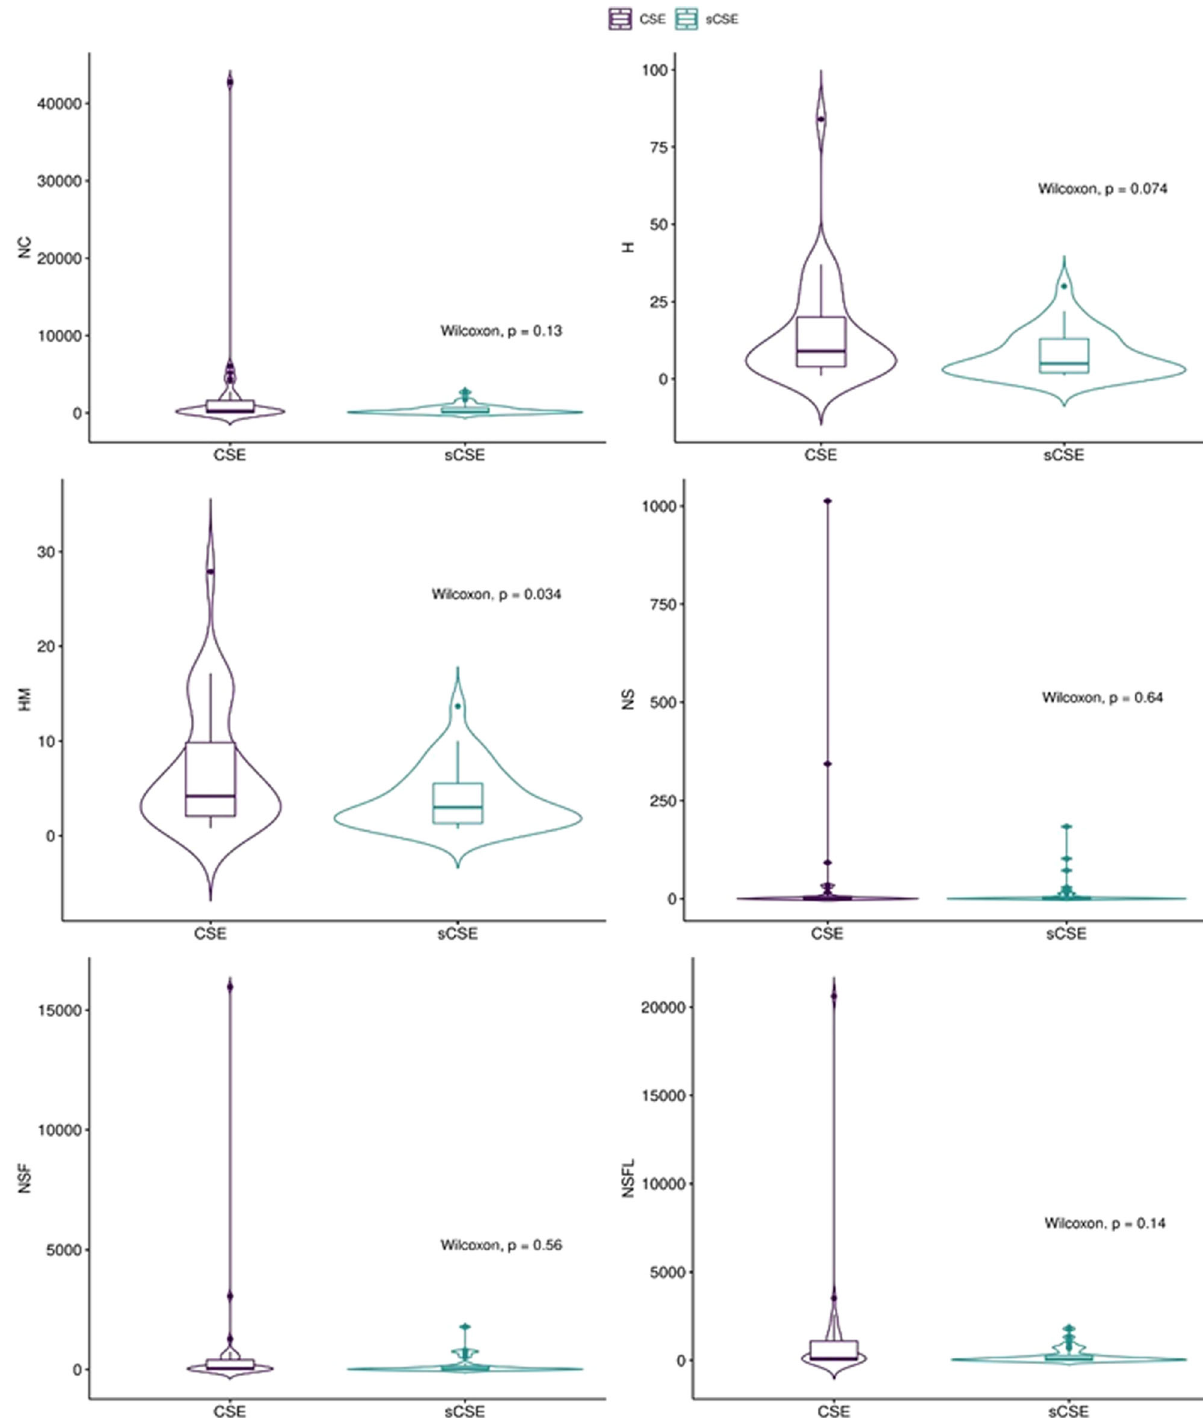
Fig. 6 Box-violin plots according to group: CSE and sCSE and bulk impact and authorship order adjusted impact indices. Source: the authors based on (Scopus, 2020a; Ioannidis et al., 2016). Note: NC: total citations; H: H index; Hm: Schreiber Hm index; NS: total citations for articles of which the scientist is the single author; NSF: total citations for articles of which the scientist is the single or the fi rst author; NSFL: total citations for articles of which the scientist is the single, fi rst, or last